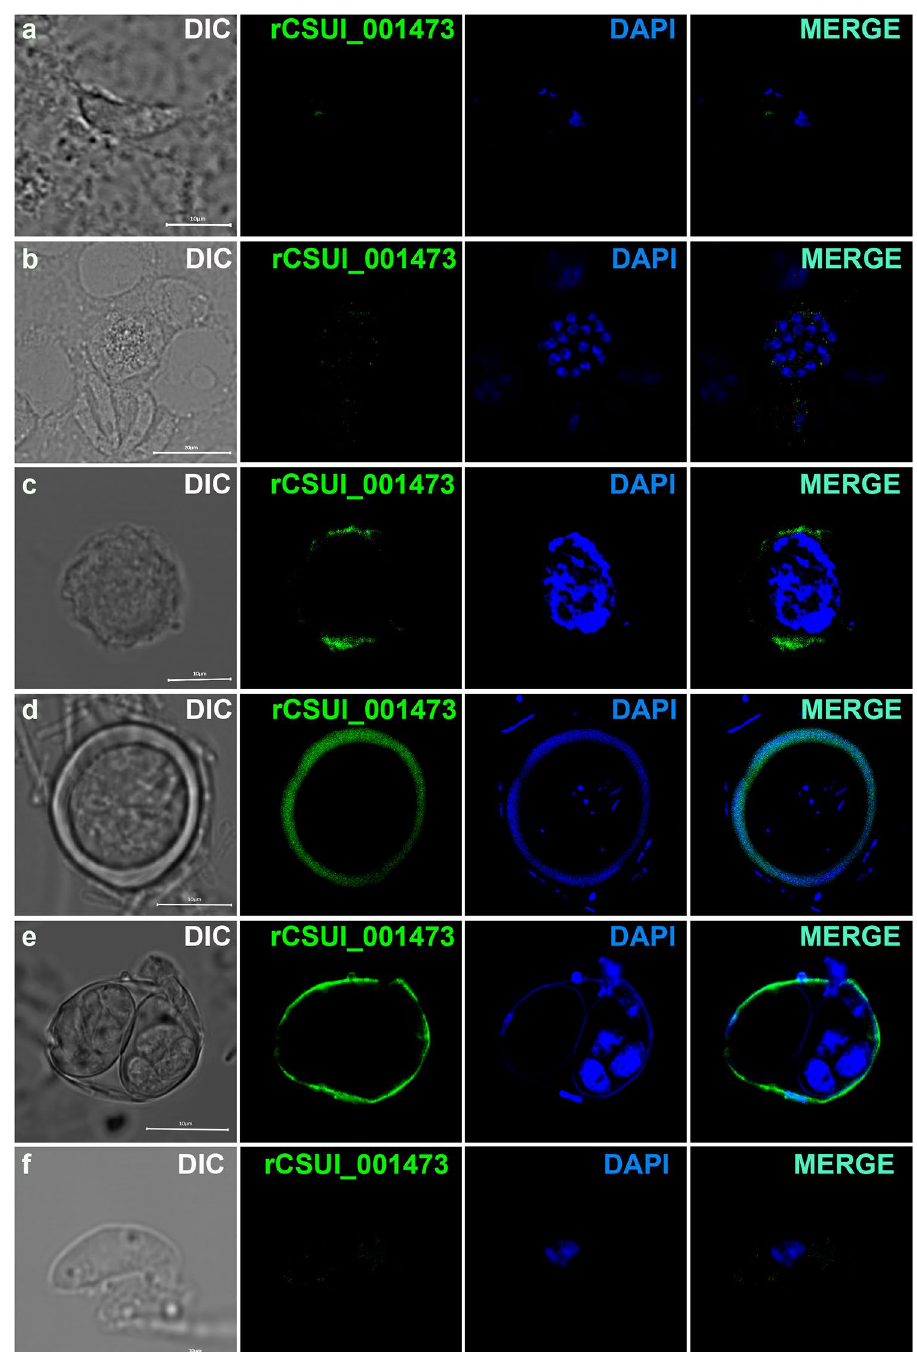
Figure 5. Localization of CSUI_001473 antigens in differents C. suis stages. ( a ) Merozoite from day 6 of in vitro culture. ( b ) Microgamont from day 9 of culture. ( c ) Macrogamont from day 9 of culture. ( d ) Unsporulated oocyst from day 14. ( e ) Sporulated oocyst ex vivo (isolated from the feces of experimentally infected piglets). ( f ) Sporozoite released from in vitro excysted oocysts. DIC, differential interference contrast microscopy; DAPI staining appears in blue; green indicates binding of anti-rCSUI-001473 antibodies, and turquoise indicates merged results. Scale bar = 10